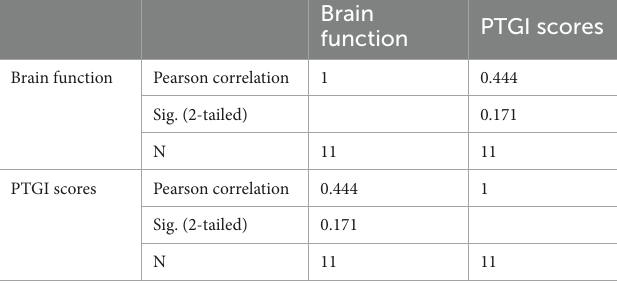
TABLE 5 Pearson correlation for brain function and PTG during PE.